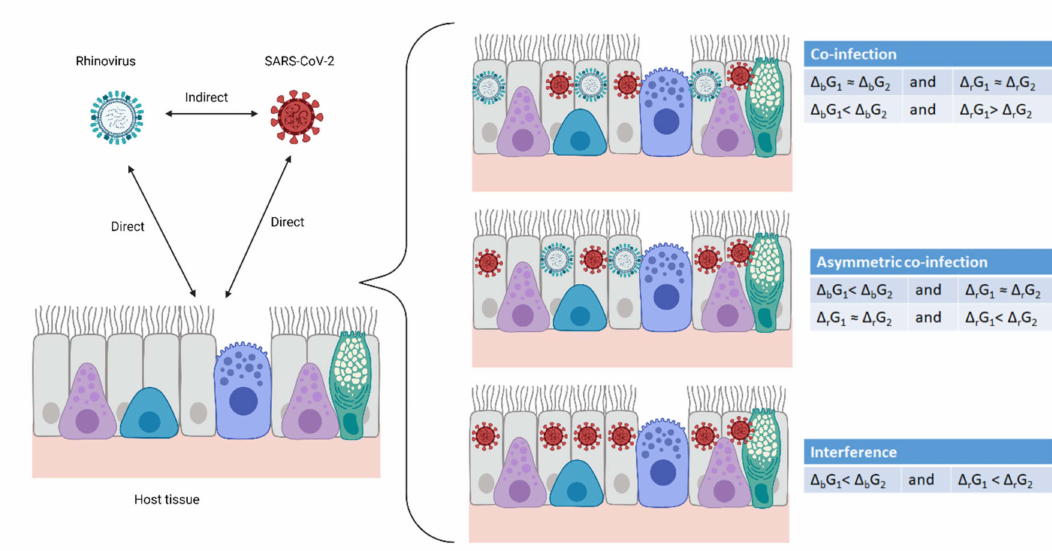
Figure 2. Virus–host and virus–virus interactions. Two viruses and a multicellular organism make two direct interactions— each virus with the host. In this way, the viruses interact with each other, indirectly through the host. The result can be co-infection, asymmetric co-infection and interference. Created with